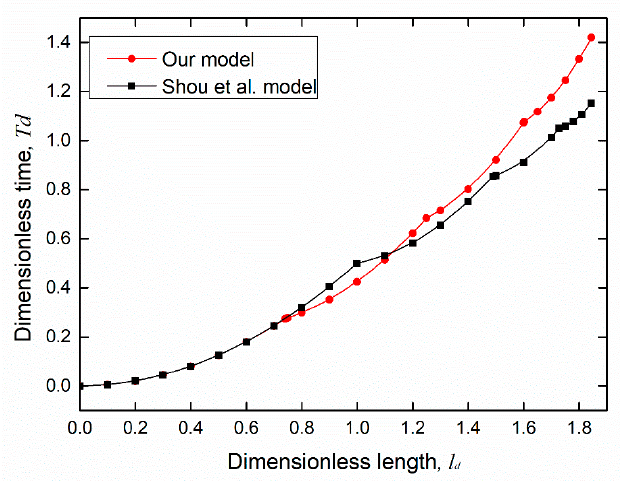
Figure A1. Lines were interpolated by beta spline interpolation. Figure B1. Lines were interpolated by beta spline interpolation.